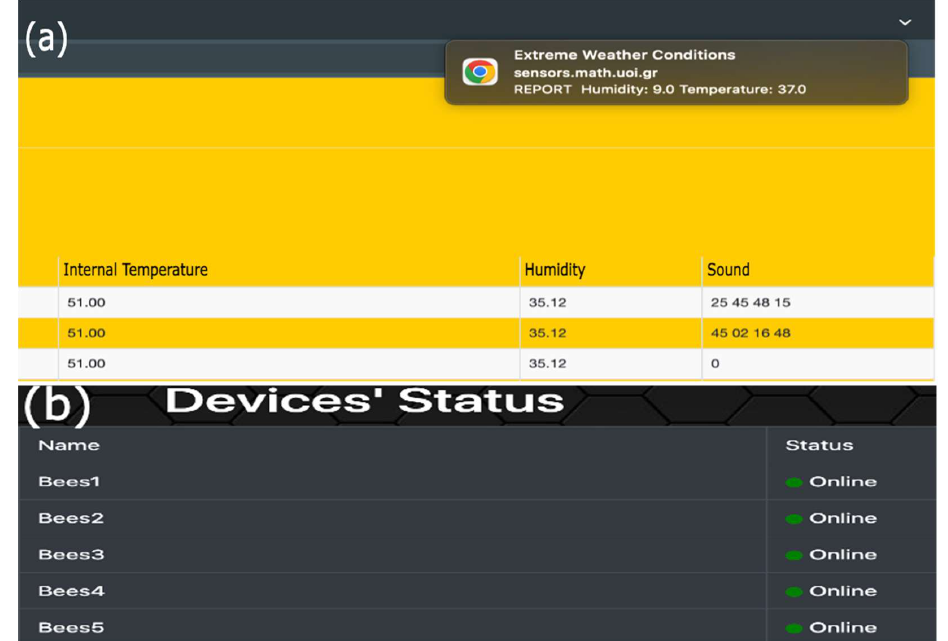
Figure 3. ( a ) Push notification service for unsuitable weather conditions, ( b ) Monitoring and probing service User Interface.